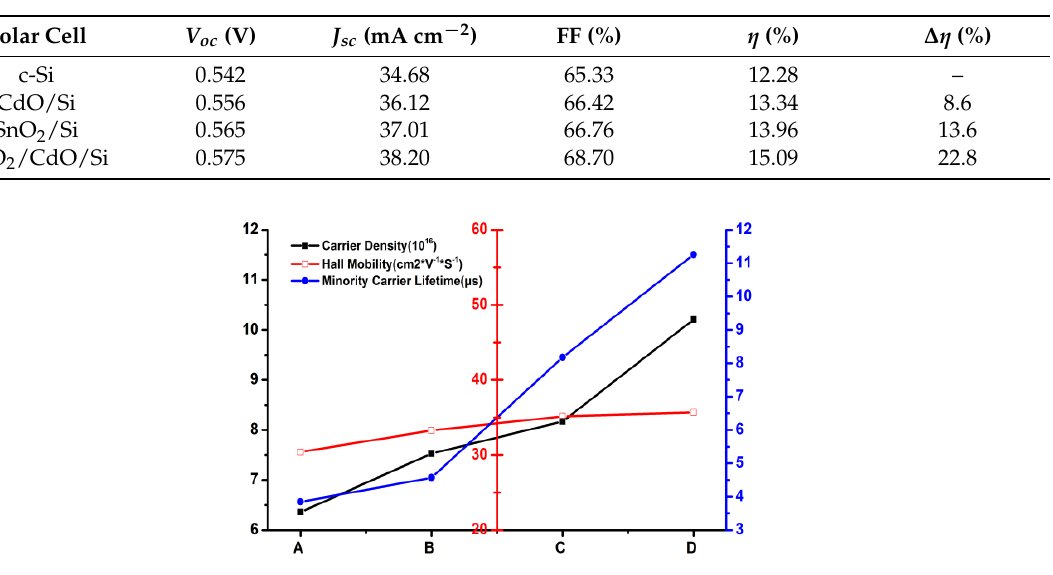
Figure 5. Carrier density, Hall mobility, and minority carrier lifetime properties of ( A ) c-Si solar cell, ( B ) CdO/Si SLSC, ( C ) SnO 2 /Si SLSC, and ( D ) SnO 2 /CdO/Si DLSC.